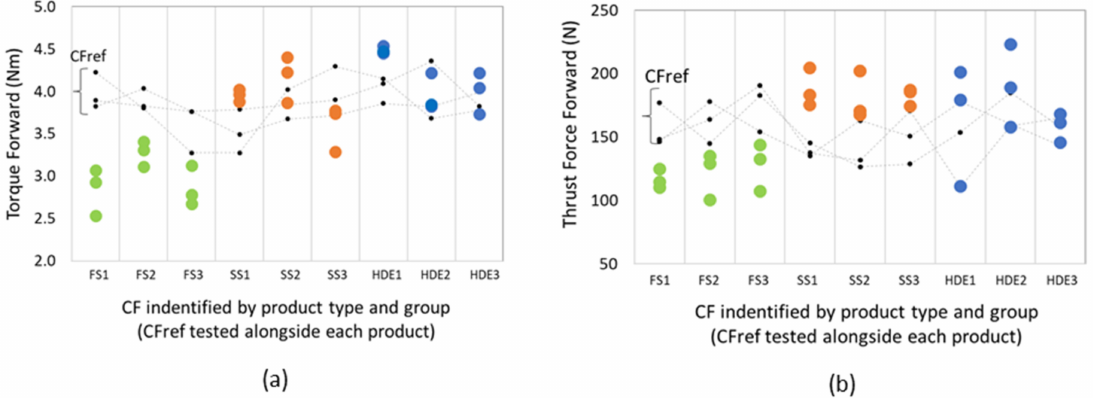
Figure 7. Tf ( a ) and Ff ( b ) obtained for each CF product with group